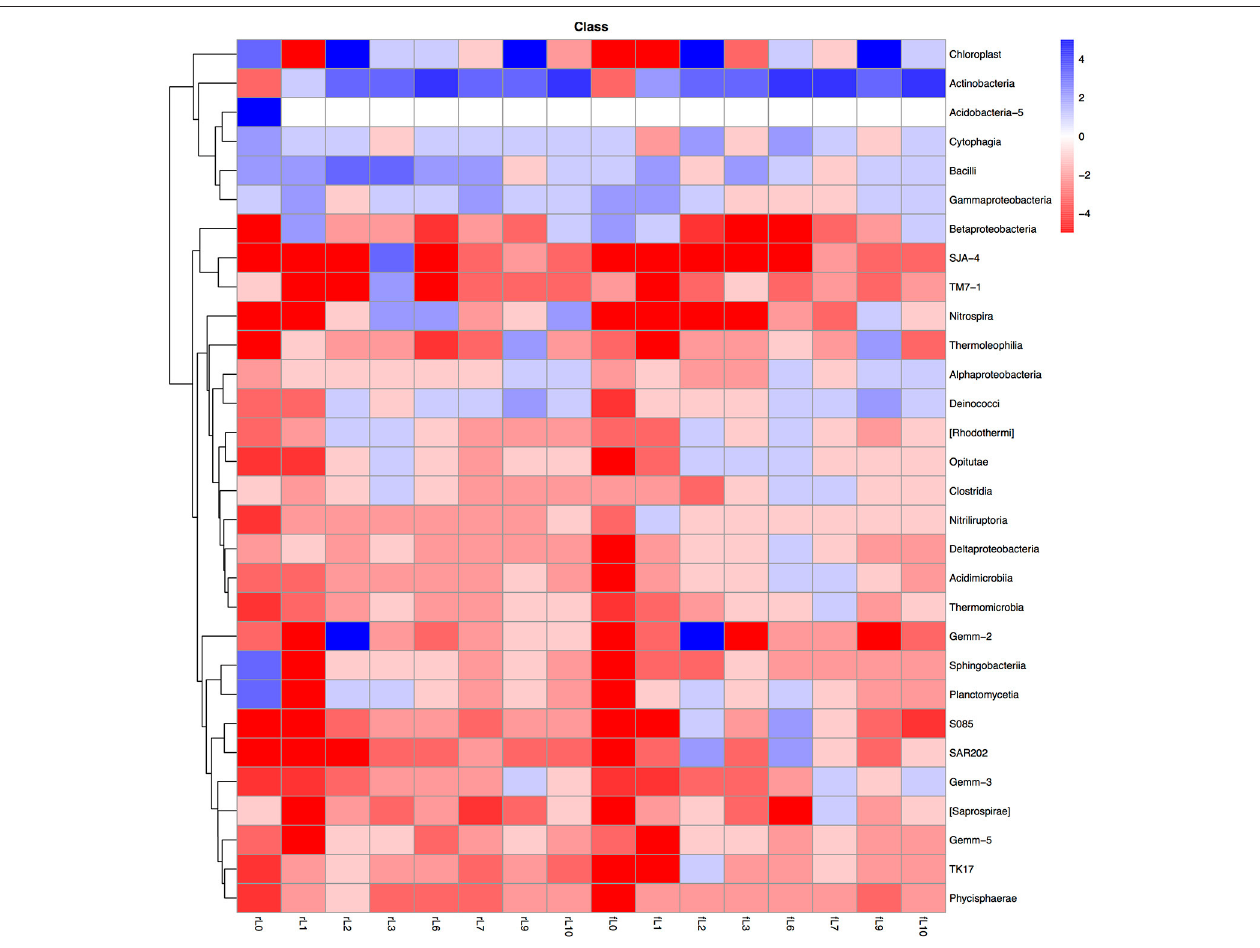
FIGURE 8 | Heatmap of the ratio between the relative abundance of the different bacterial classes in the unamended soil vs. the soil amended with maize plantlets or its neutral detergent fiber (NDF). Legends to the figure can be found in Figure 5 .